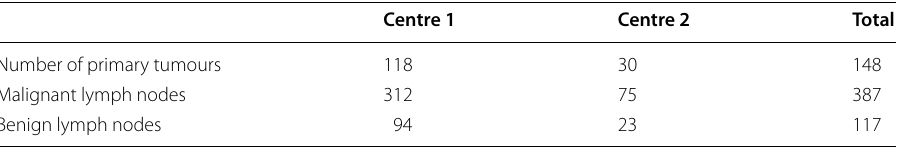
Table 2 Overview of included lymph nodes and primary tumours